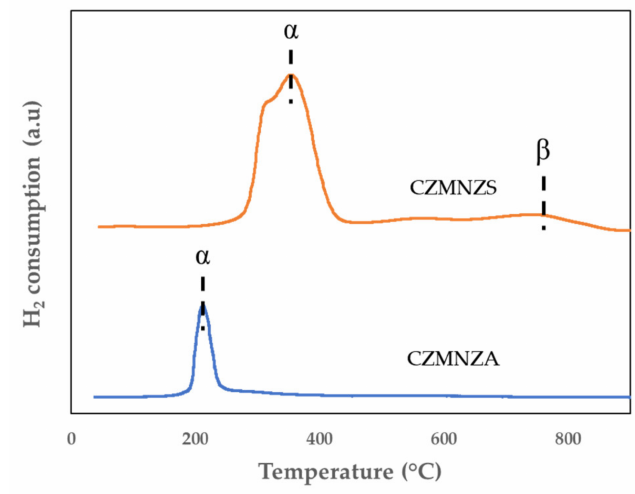
Figure 10. H 2 -TPR profiles of CZMNZA and